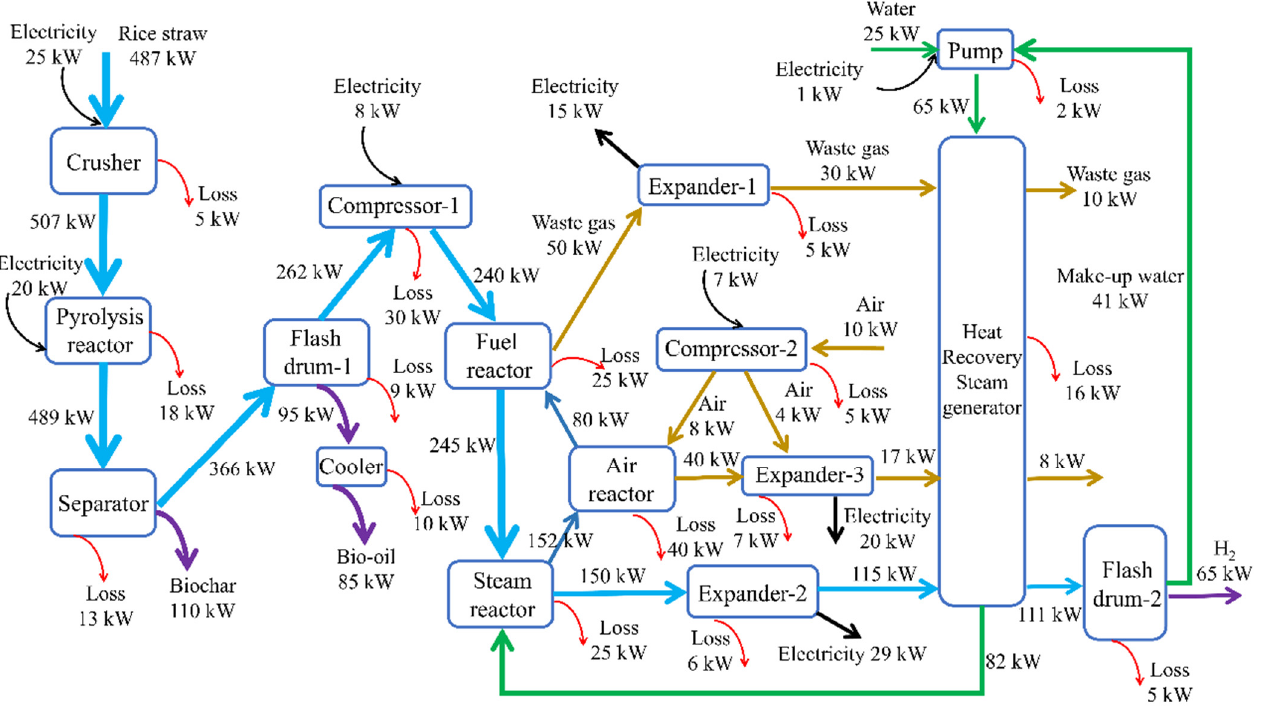
Figure 2. Exergy fl owchart of the proposed process. Figure 2. Exergy flowchart of the proposed process. Table 3. Electricity results of the proposed process. Table 3. Electricity results of the proposed